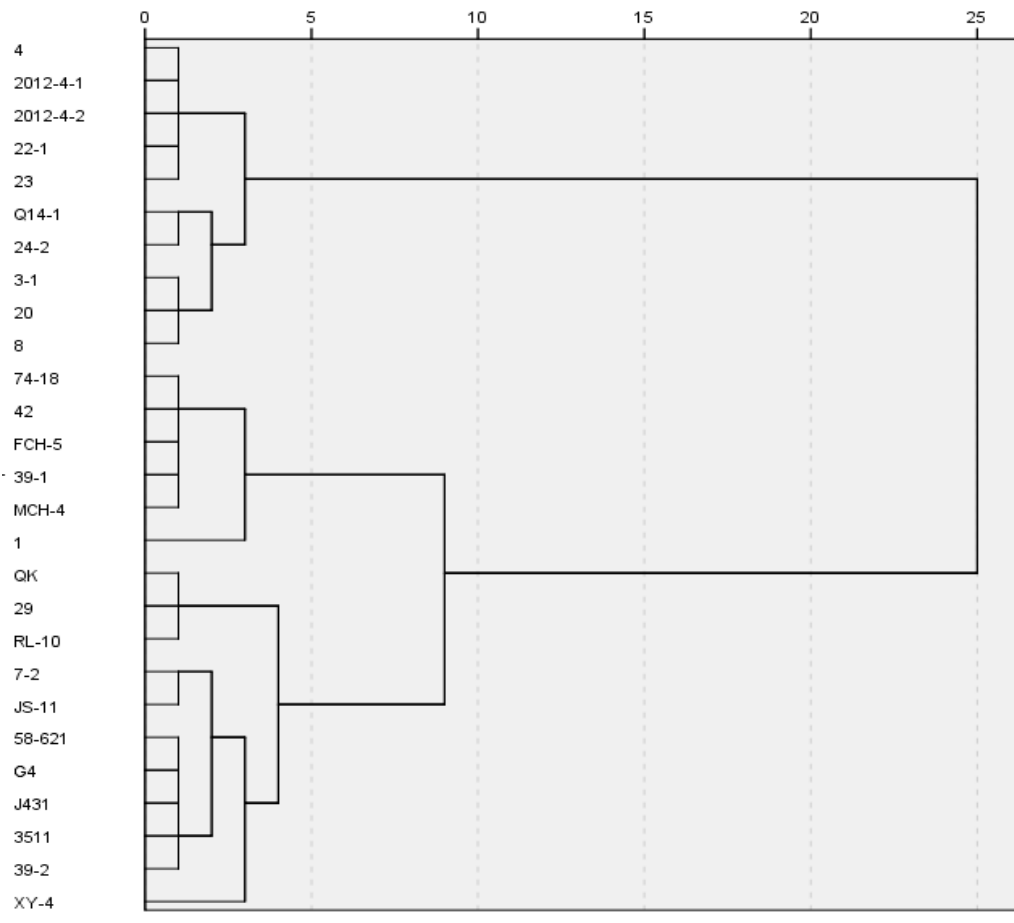
Figure 1. Cluster classification of 27 cucumber accessions based on data of 20 indexes.